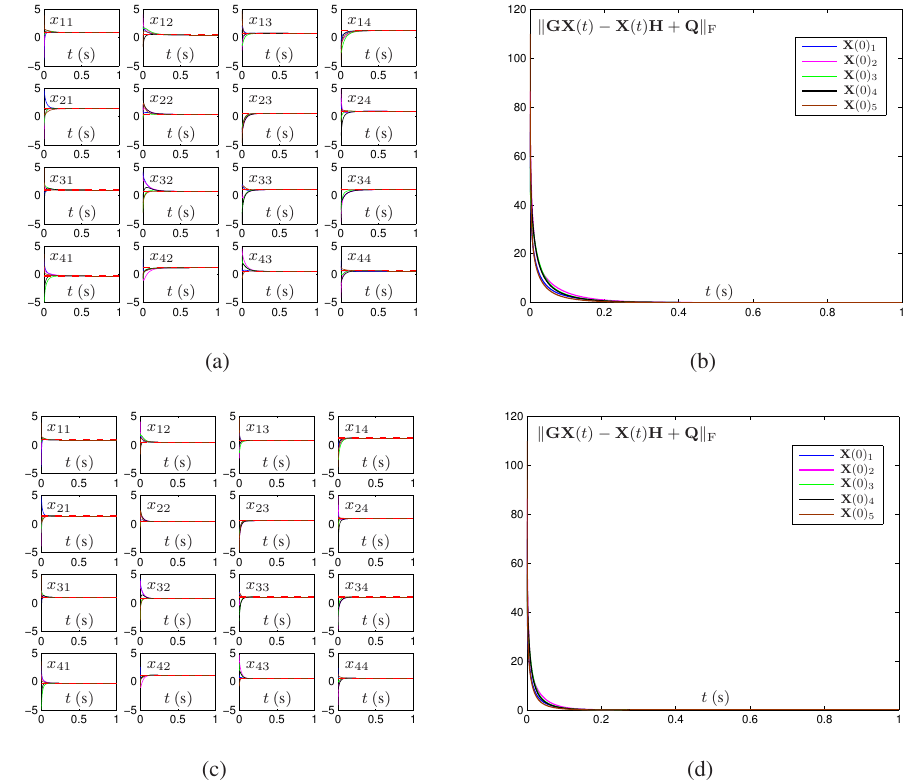
Figure 4. Convergence behaviors of neural state X ( t ) and residual error (cid:107) GX ( t ) − X ( t ) H + Q (cid:107) F of GNN models (6) and (9) starting from 5 randomly created initial values for Sylvester equation in example 2, where red dashed lines denote the exact solution. ( a ) Neural state X ( t ) of GNN model (6). ( b ) Residual error (cid:107) GX ( t ) − X ( t ) H + Q (cid:107) F of GNN model (6). ( c ) Neural state X ( t ) of GNN model (9). ( d ) Residual error (cid:107) GX ( t ) − X ( t ) H + Q (cid:107) F of GNN model